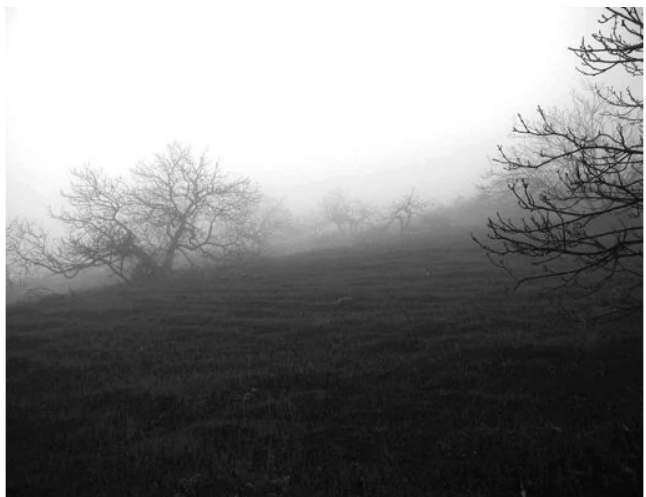
Fig. 2 - Chestnut trees in The south of